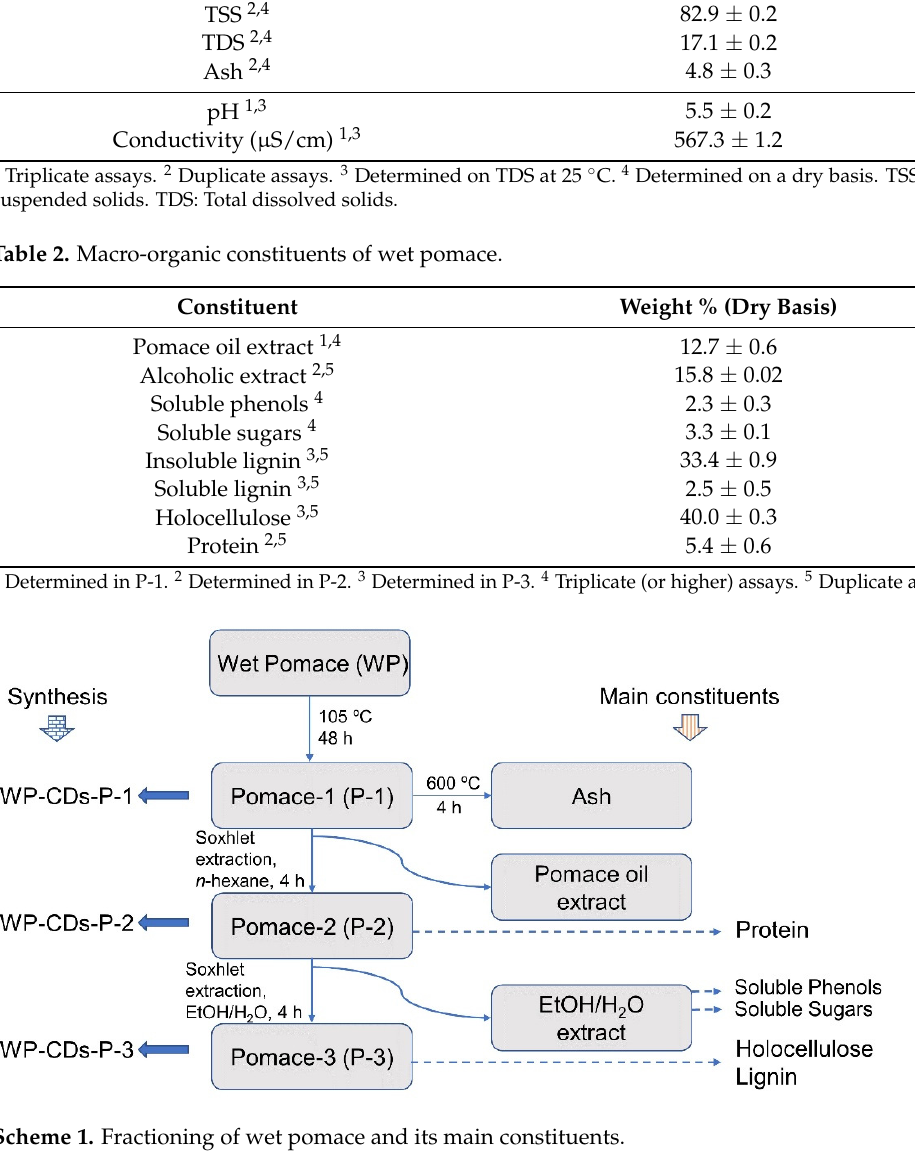
Table 2. Macro-organic constituents of wet